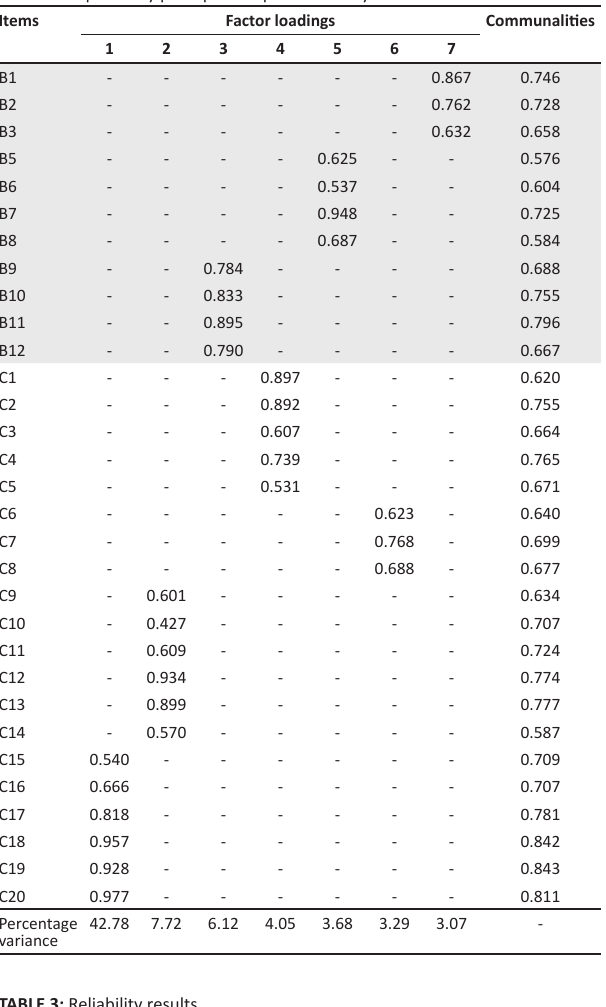
TABLE 2: Exploratory principal components analysis.